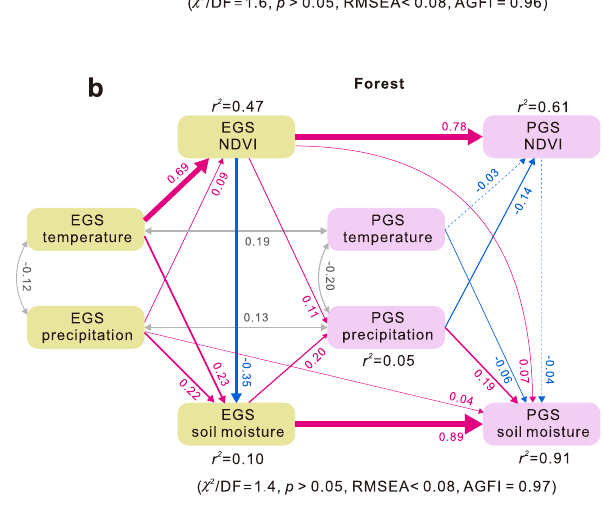
Fig. 3 Pathways for early-season factors controlling peak-season growth. Structural equation modeling (SEM) analyses were conducted for three main vegetation types: temperate grassland (Tibetan Plateau excluded) ( a ), forest ( b ), and arctic tundra and shrubland ( c ) (see Supplementary Fig. 9). Double-headed gray arrows indicate covariance between variables. Single-headed arrows indicate the hypothesized direction of causation, with positive and negative relationships in pink and blue, respectively. Solid lines represent relationships that are signi fi cant statistically ( p < 0.05), and hatched lines represent relationships that are not signi fi cant statistically ( p > 0.05). Arrow thickness is proportional to the strength of the relationship and to the standard path coef fi cients adjacent to each arrow. The explained variance ( r 2 ) is labeled alongside each response variable in the model. EGS and PGS represent early and peak growing